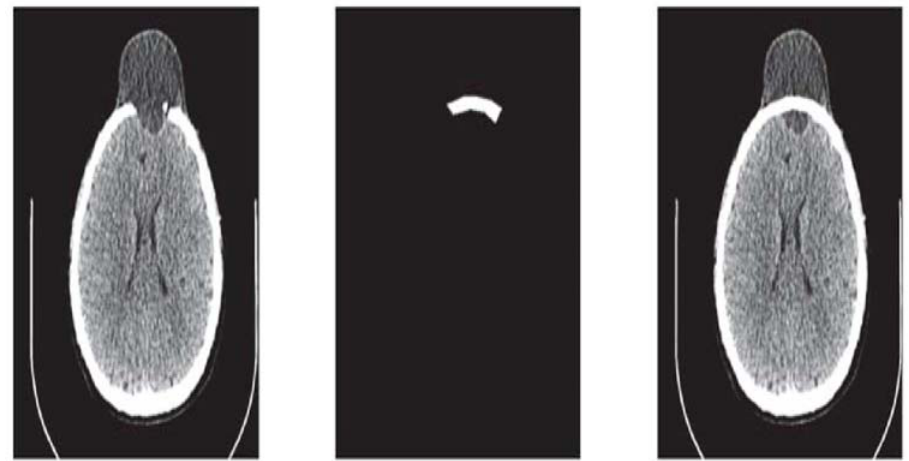
Fig 6. Missing data in Dicom format of slice